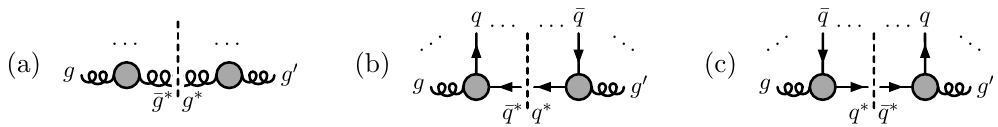
Figure 1 . Factorisation channels of gg -basis colour-ordered